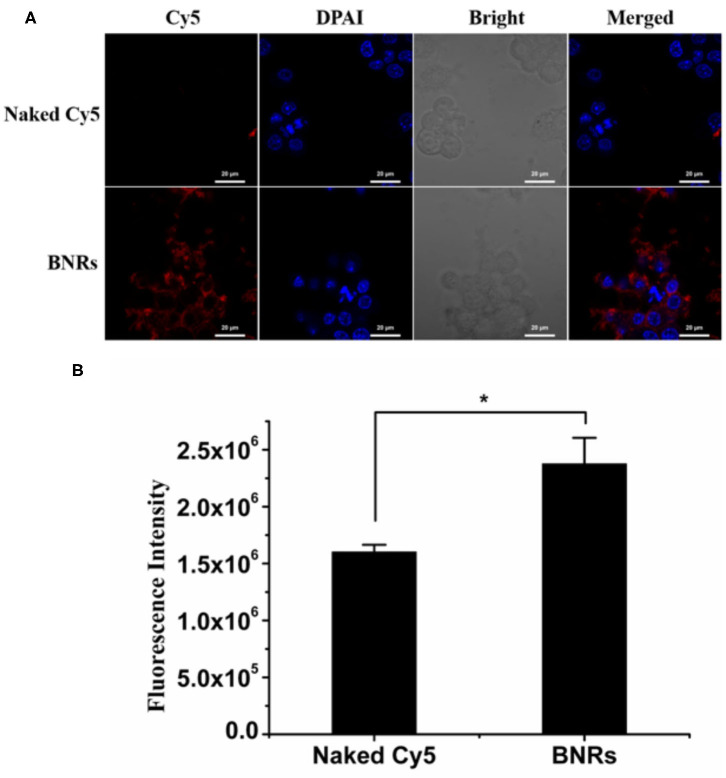
Uptake in macrophages. Uptake of Cy5-labeled BNRs in RAW 264.7 cells was tested by (A) CLSM and (B) flow cytometry, following incubation at a dye concentration of 100 nM at 37°C for 4 h (mean ± SD, n = 3, *P < 0.05). The scale bar is 10 μm.